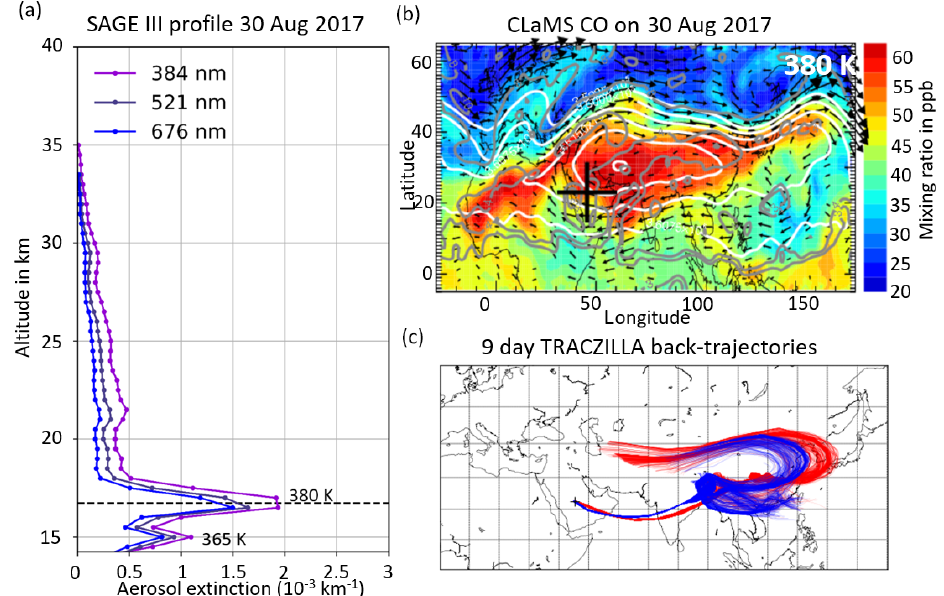
Figure B1. (a) SAGE III aerosol extinction values for the profile taken on 30 August 2017 at 22.47 ◦ N and 45.18 ◦ E. The dotted black line represents the given tropopause height by the SAGE III data set. (b) ClaMS CO map at 380K. Grey lines represent the PV contours at 3.6PVU. The determination of the AMA PV transport barrier works only on a few days in 2017. White lines show the Montgomery stream function. The position of the measurement profile from (a) is indicated with the black cross. (c) The 1000 9d back-trajectories with respect to the altitude and position of the two peaks shown in (a) . The beginning of the blue trajectories corresponds to the peak at 15km altitude (365K), the red trajectories to the peak at 17km altitude (380K) in (a)